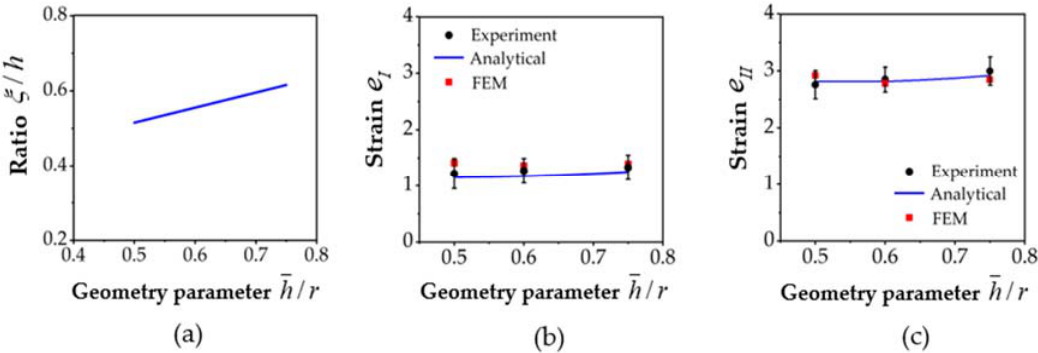
Figure 7. The characteristics of the strain distribution for Mode 2, obtained by the analytical model (continuous lines), and by finite element (FE) simulations (red dots) for the die angle α = 120 and for the friction value of m = 0.2. ( a ) The predicted width of Zone I; ( b ) the von Mises strain in Zone I; and ( c ) the von Mises strain in Zone II.